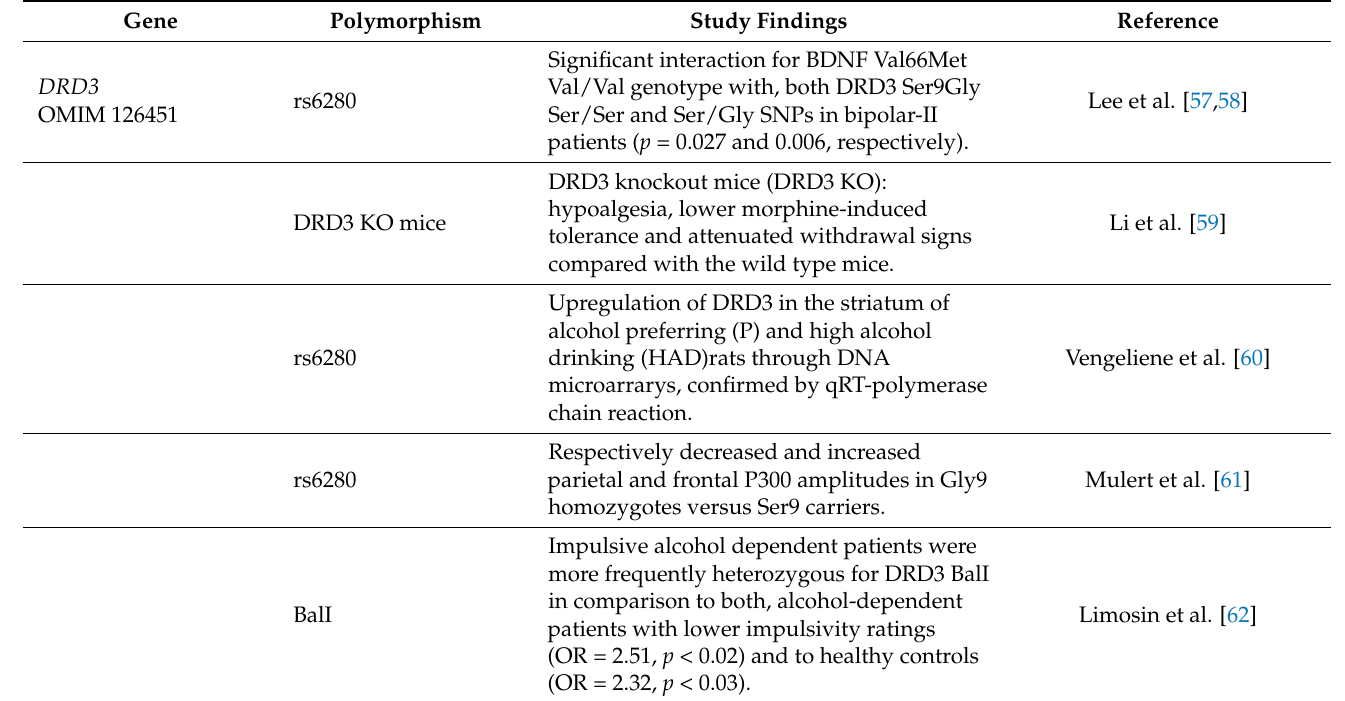
Table 1. DRD3 gene polymorphisms and RDS—Not specific for Opioids (a